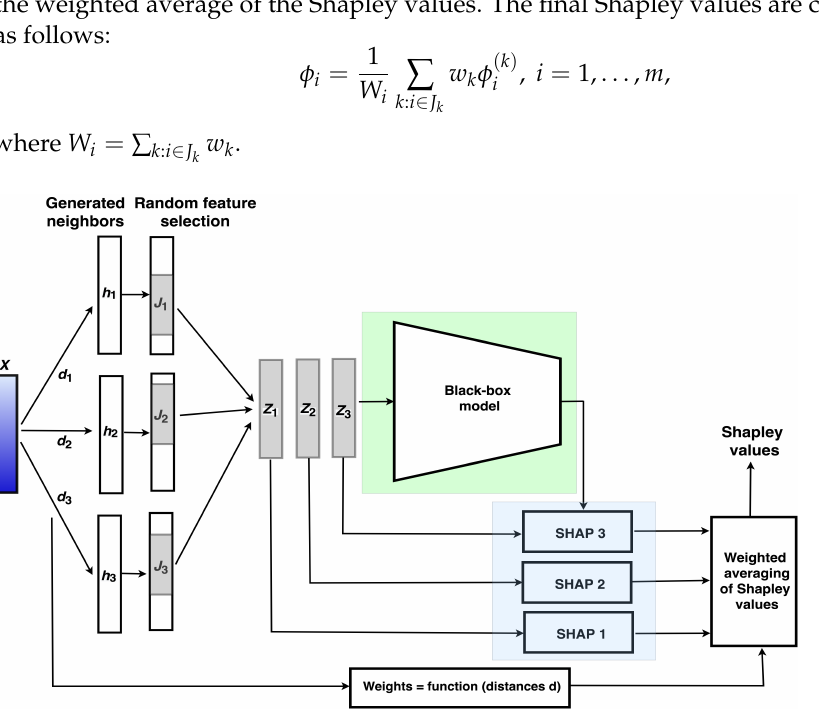
Figure 2. A scheme of the